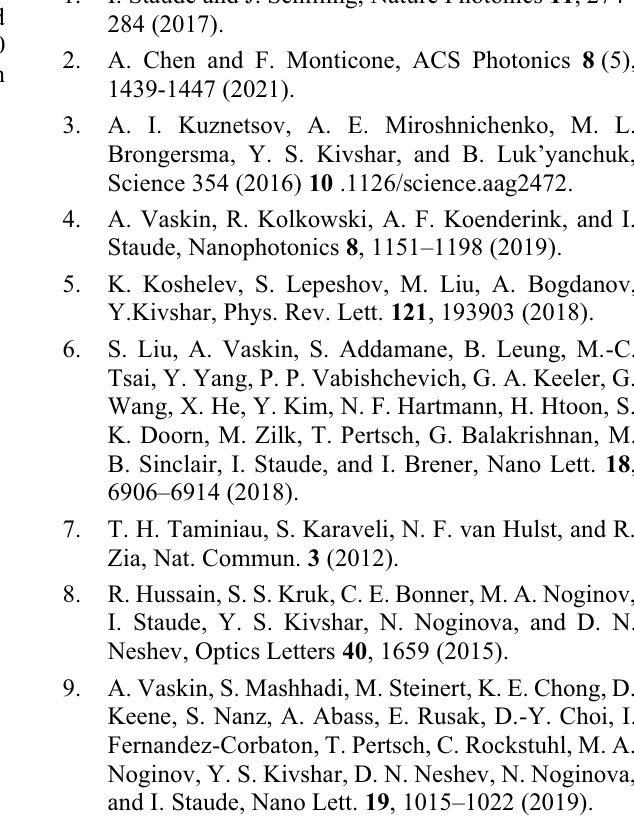
Fig. 3. Measured BFP images of the sample at 590 nm and 610 nm wavelength, corresponding to the electric and magnetic dipole transition, respectively.